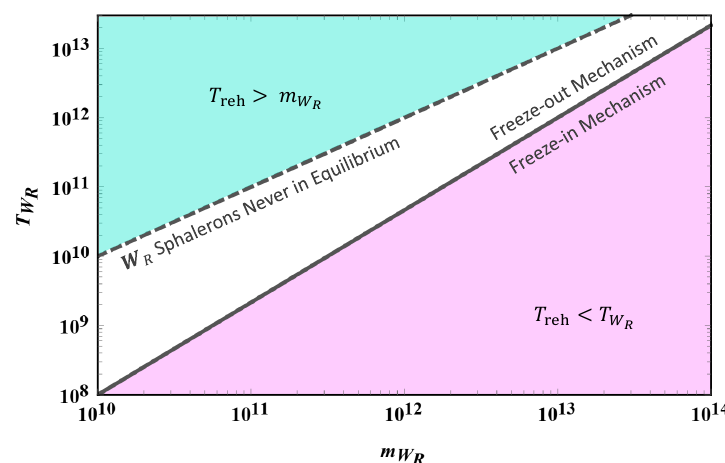
. The (pink) shaded Figure 9 . The freeze-out temperature of W R interactions in terms of m W R area shows regions with T (condition C2) and below the solid line, the secondary (post- reh < T W R inflationary) abundance of RHNs are not generated by freeze-out but instead by the freeze-in mechanism. In the (blue) shaded region we have T , so W sphalerons are never in reh > m W R R thermal equilibrium below the dashed